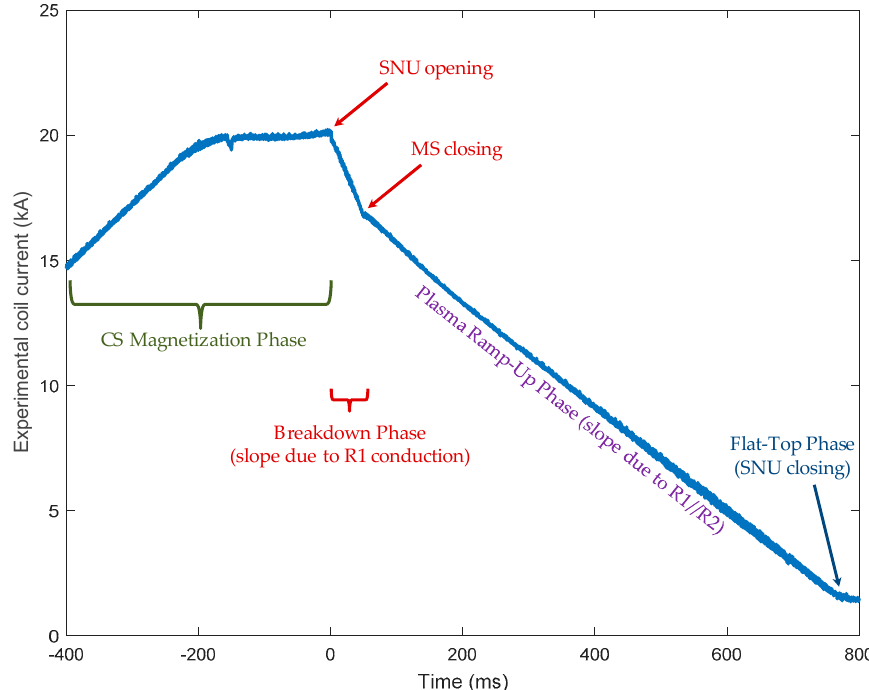
Figure 2. Phase and operations of CS with a SNU described on experimental data. The showed current waveform was measured during a full-current (20 kA) and full-voltage (5 kV) test of the CS SNU prototype performed in the ENEA tokamak (FTU) [8].